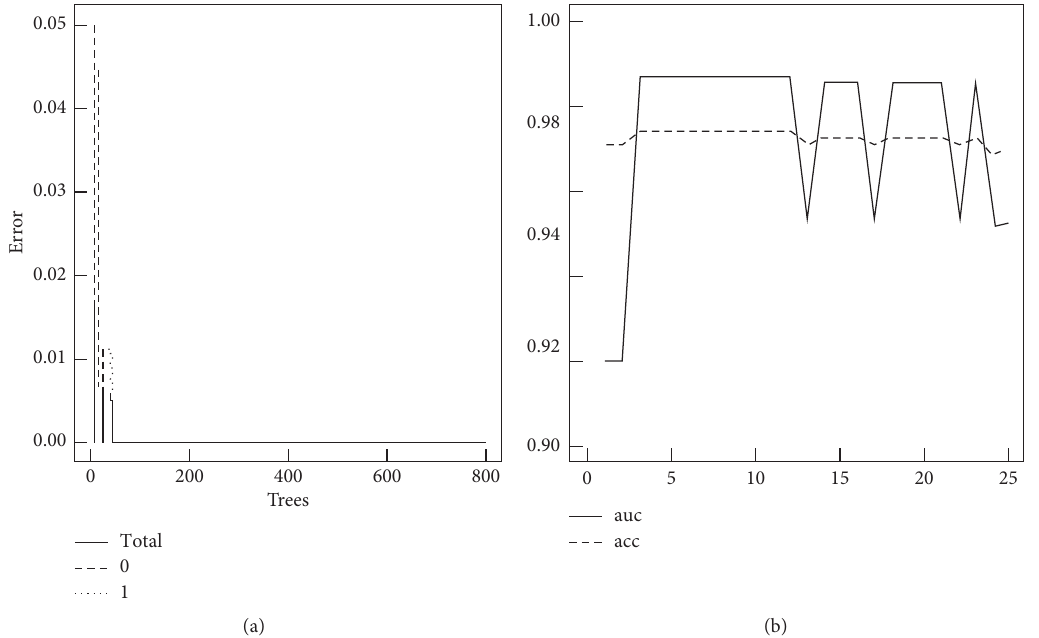
Figure 1: Parameter selection of the random forest algorithm. (a) ntree. (b)